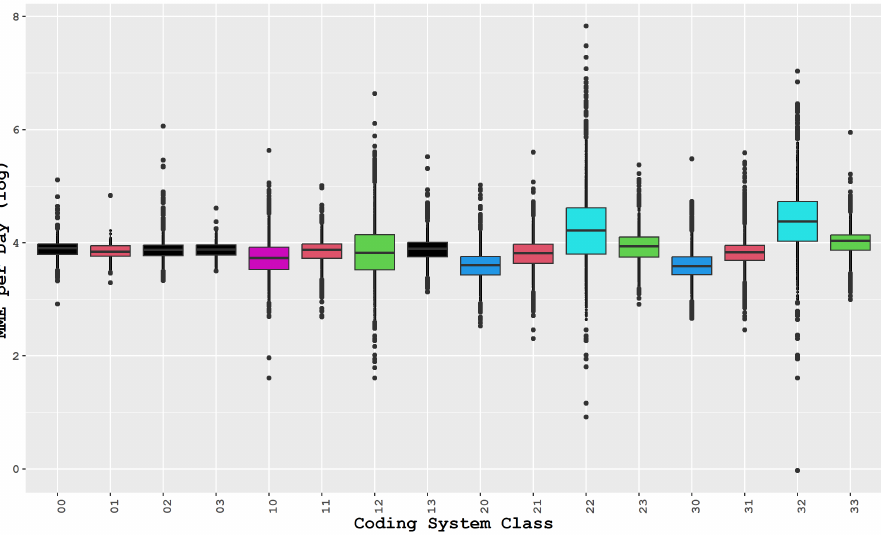
Figure 3. MME per day box-plot with Tukey’s results for opioid drugs. Classes with overlapping confidence intervals are plotted using the same